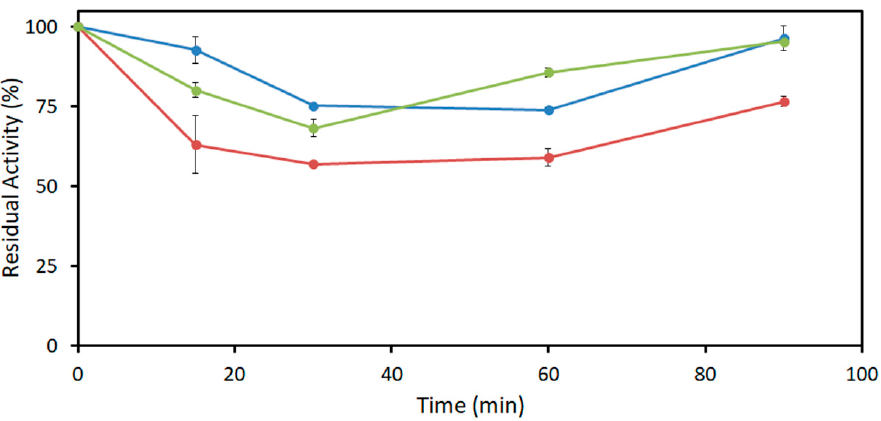
Figure 4. Time-dependent activity of Pa DERA C49M during incubation at different acetaldehyde concentrations (100 mM (blue), 200 mM (red) and 300 mM (green)) to estimate the residual activity using the standard assay protocol. The residual activity after incubation in the absence of acetaldehyde was 3.5 U/mg and was normalized to 100%.